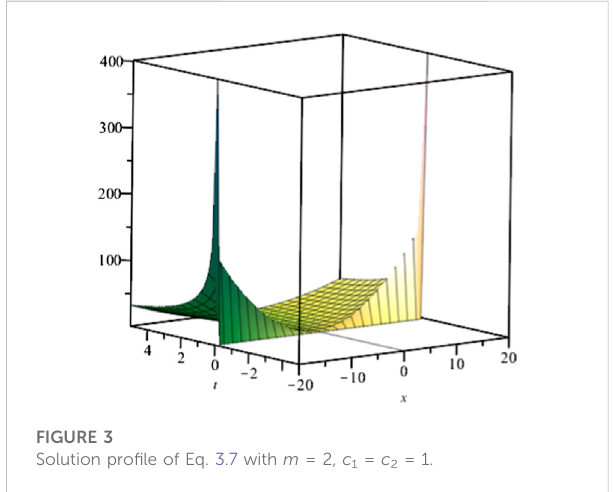
FIGURE 3 Solution pro fi le of Eq. 3.7 with m = 2, c 1 = c 2 =